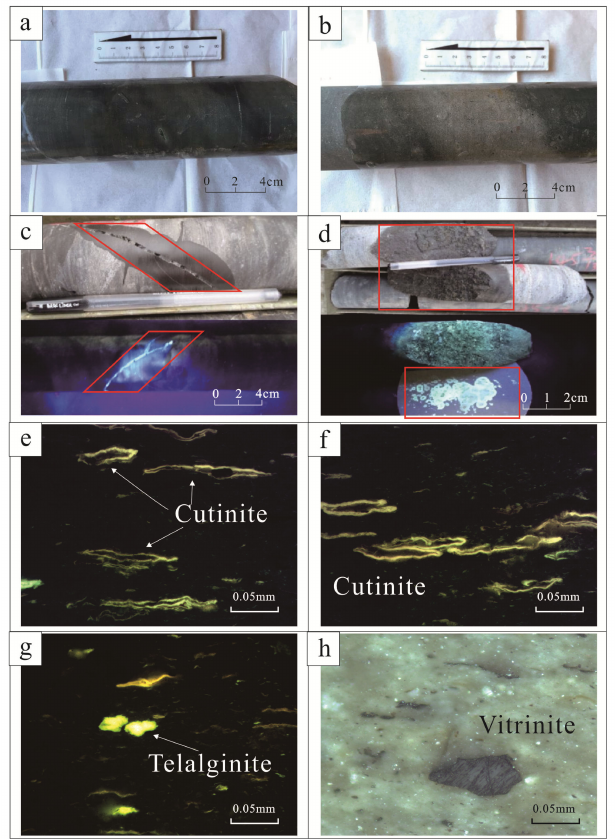
Figure 4. Photomicrographs of sediments from the Hengtongshan Formation; ( a , b ) are core photos; ( c , d ) are oil traces in rock cores under fluorescence. Oil traces are marked with red frame and show pale yellow under fluorescence; ( e – h ) are photos from the